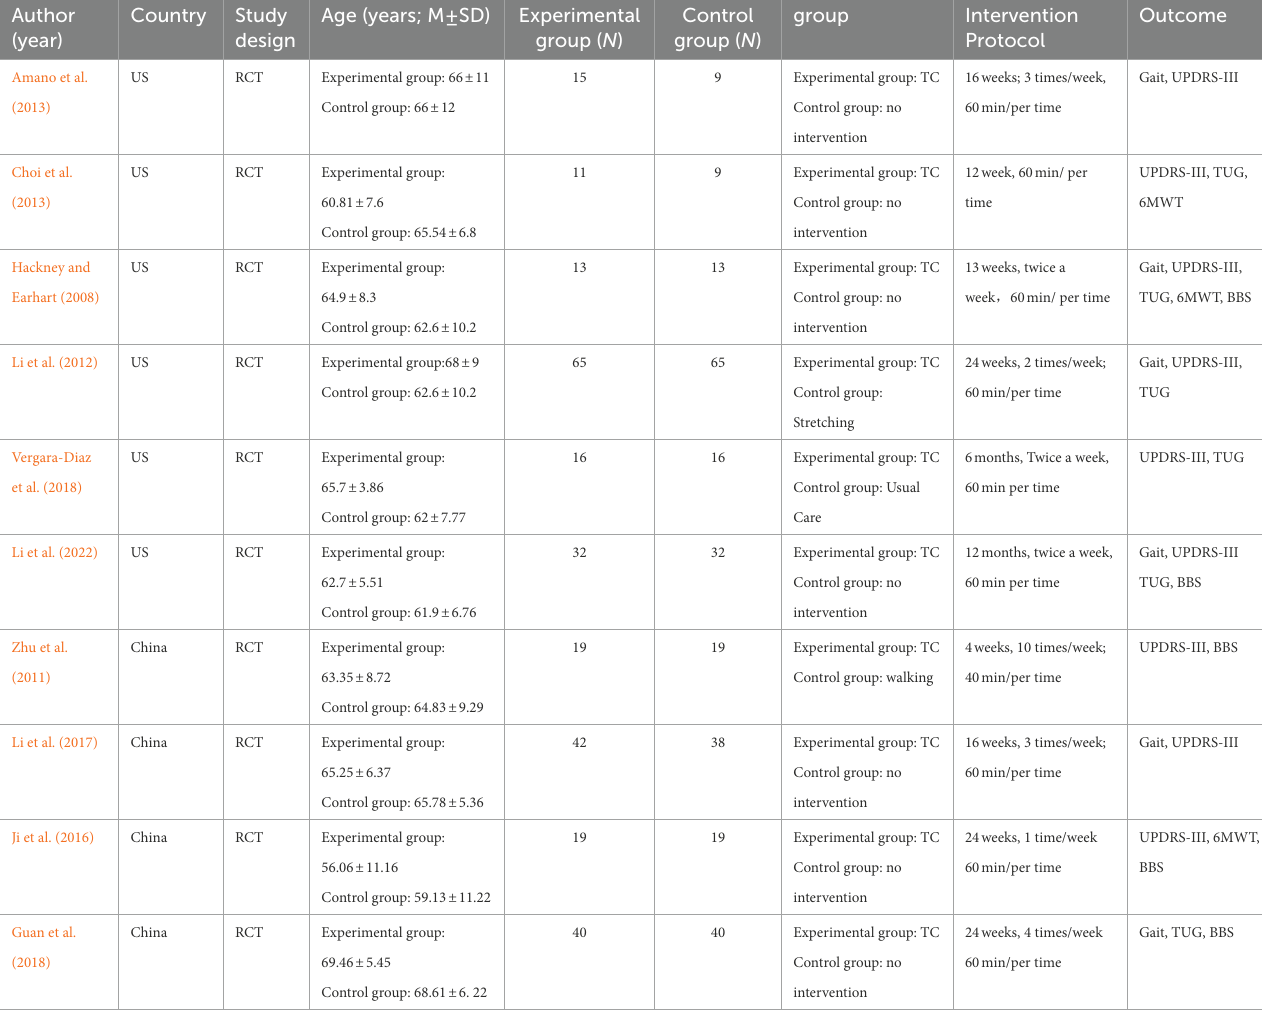
TABLE 1 Characteristics of the included